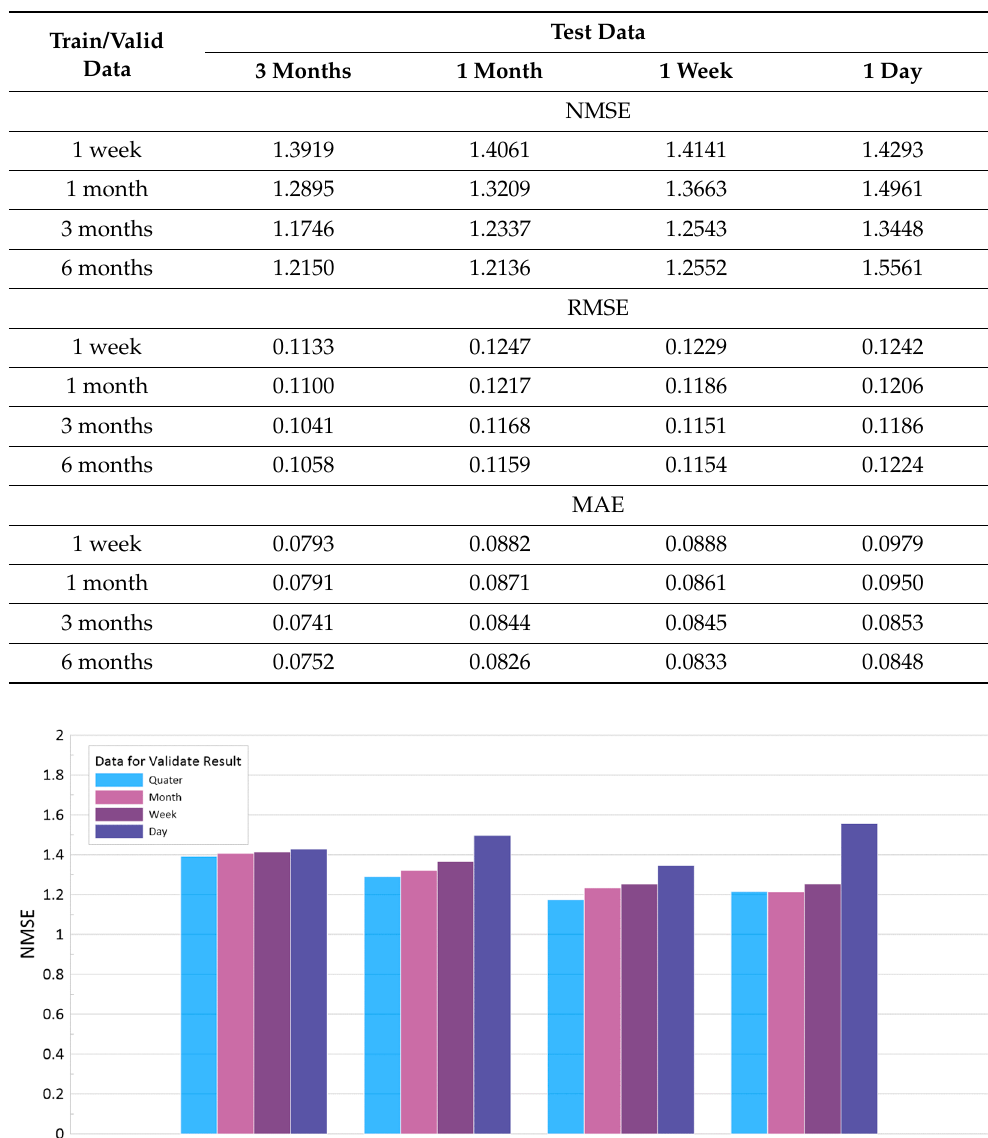
Table 7. Model validation results according to the length of data.